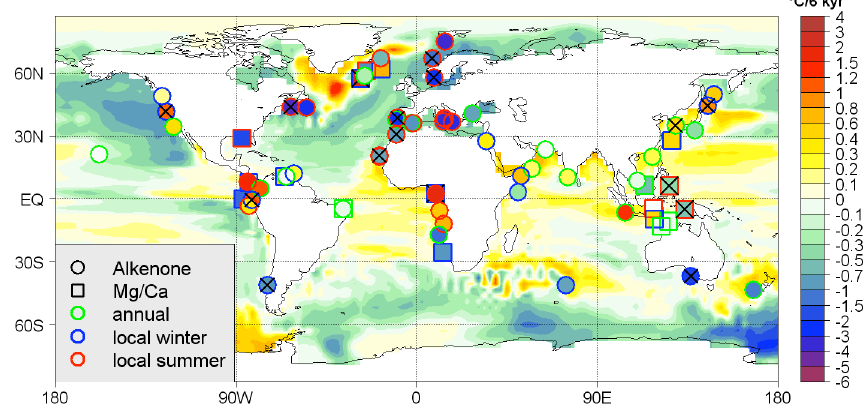
Fig. 5. Global SST trends of the annual mean ECHO-G model output, and local temperature trends based on alkenone and Mg/Ca recon- Figure 5 structions. The circles and squares localize the alkenone and Mg/Ca records, respectively, the colours that fill the circles/squares show the temperature trend they record. The border colours of the circles/squares represent the annual mean/season in which the reconstruction agrees best with the model simulation. Crosses indicate the record locations where the test of the regression residuals fails to show randomness.